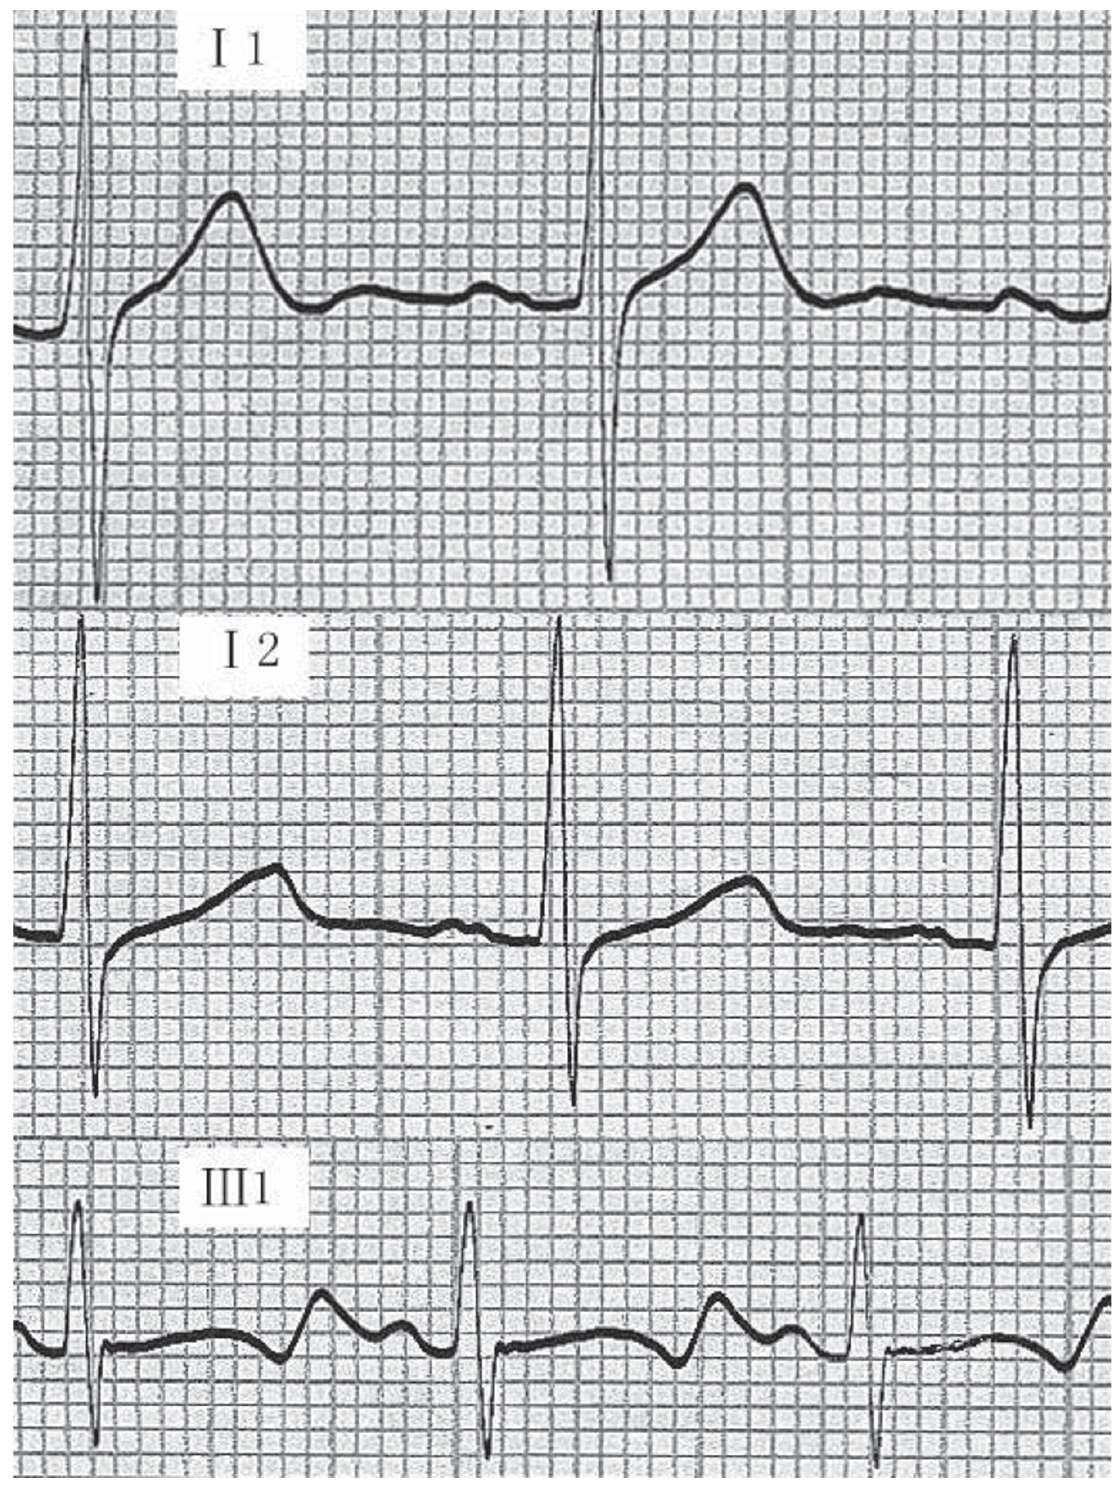
Figure 2 Representative electrocardiograms (ECG) from members of the Chinese family with LQTS. Top, ECG from a normal family member (I-1); Middle, ECG from a heterozygous mutation carrier; Bottom, ECG from a homozygous mutation